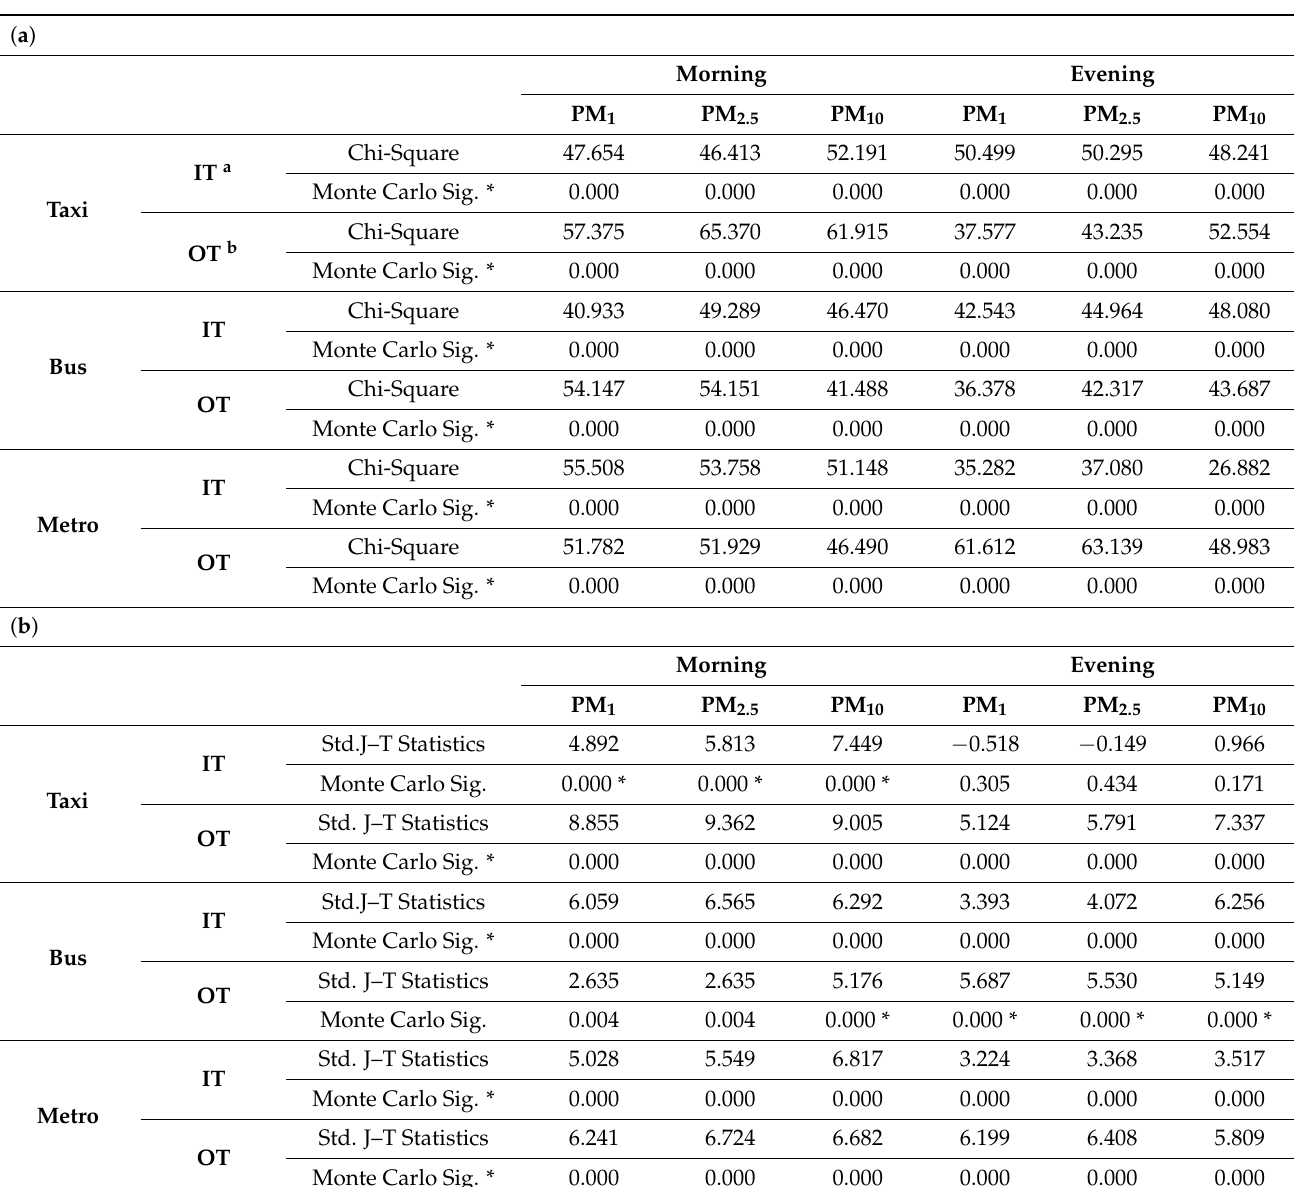
Table 2. Kruskal–Wallis (K–W) and Jonckheere–Terpstra (J–T) tests for variations in in-cabin